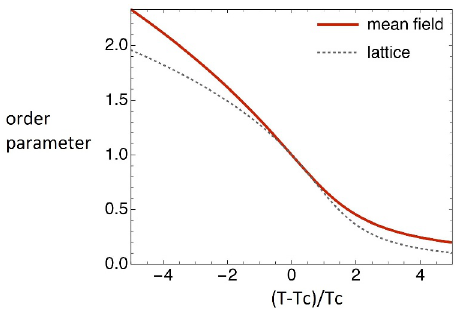
Figure 1. Comparison of mean field order parameter to the lattice in [17,